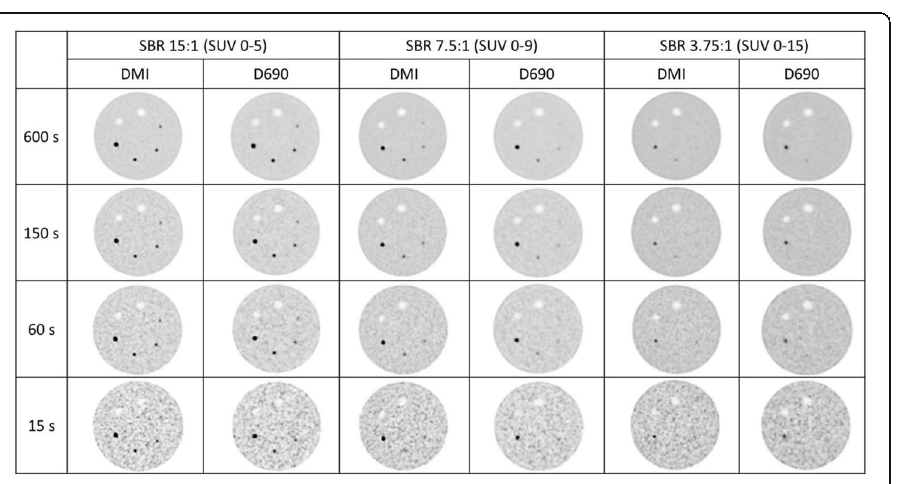
Fig. 4 Example images of the Discovery DMI and Discovery 690 for different sphere-to-background ratios (SBRs) and acquisition times. The greyscale has been adjusted for each SBR experiment to facilitate visual